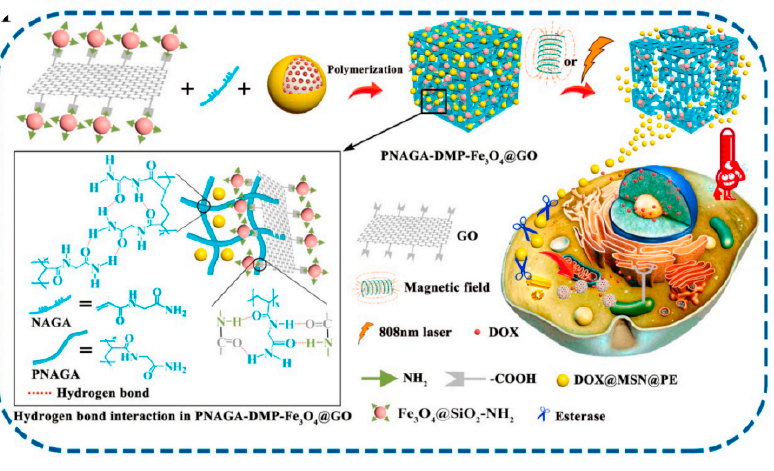
Figure 5. Composite hydrogels for tumor therapy [116].